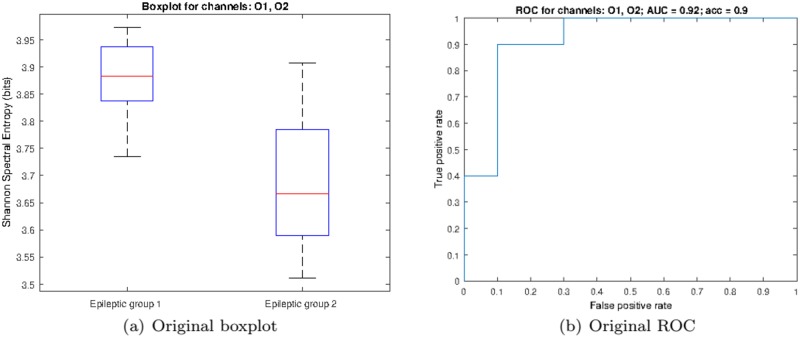
Classification analysis for electrodes O1 and O2.(a) Boxplot and (b) ROC curve corresponding to the classification analysis of the two groups of epileptic patients using values from channels O1 and O2. Red lines in the boxes mark the median and edges the 25th and 75th percentiles of the data.